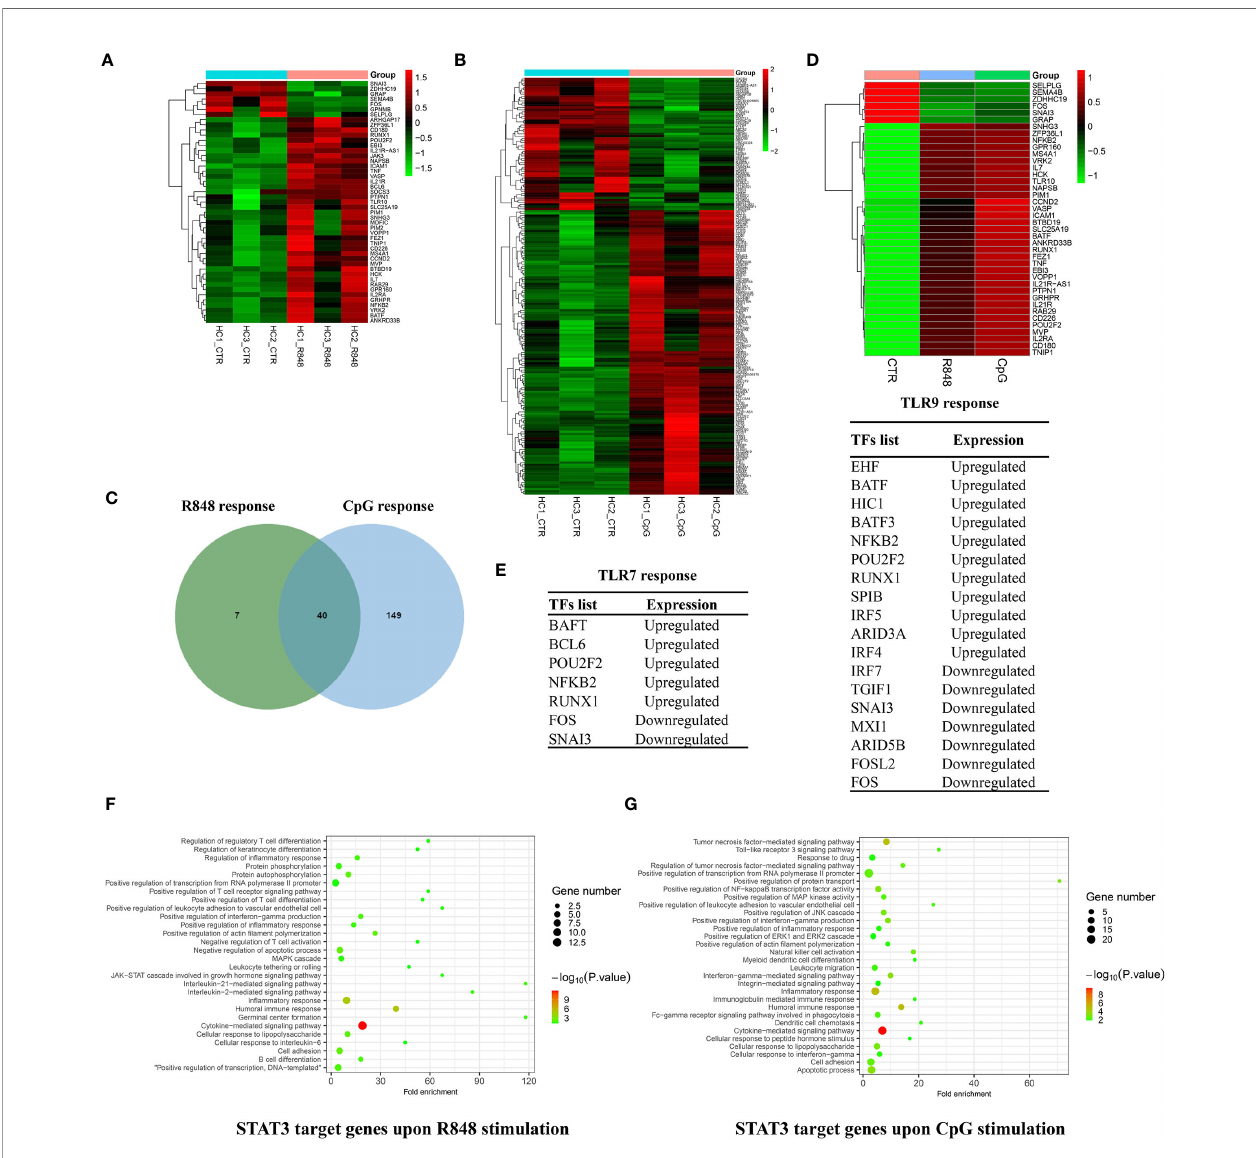
FIGURE 6 | Comparison of immediate target genes of STAT3 after TLRs activation in B cells. Heatmap showing 47 STAT3 binding genes in response to R848 stimulation (A) and 189 STAT3 binding genes in response to CpG stimulation (B) within 20 kb of their TSS. (C) Venn diagram showing the overlap of STAT3 directly regulated genes induced by R848 and CpG stimulation. (D) Heatmap showing 40 overlapped STAT3 directly regulated genes in response to R848 and CpG stimulation. (E) Gene list showing STAT3 directly regulated TFs in response to R848 simulation and CpG simulation in B cells. Visualization and Integrated Discovery (DAVID) was used to analyze biological progress (GO) terms of immediate target genes of STAT3 after TLR7 (F) and TLR9 (G) activation in B